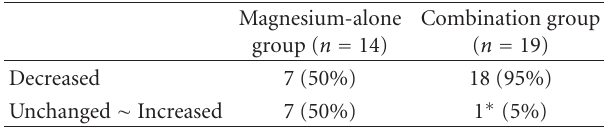
Table 3: Changes in uterine contractions at 48 hours after mag- nesium sulfate